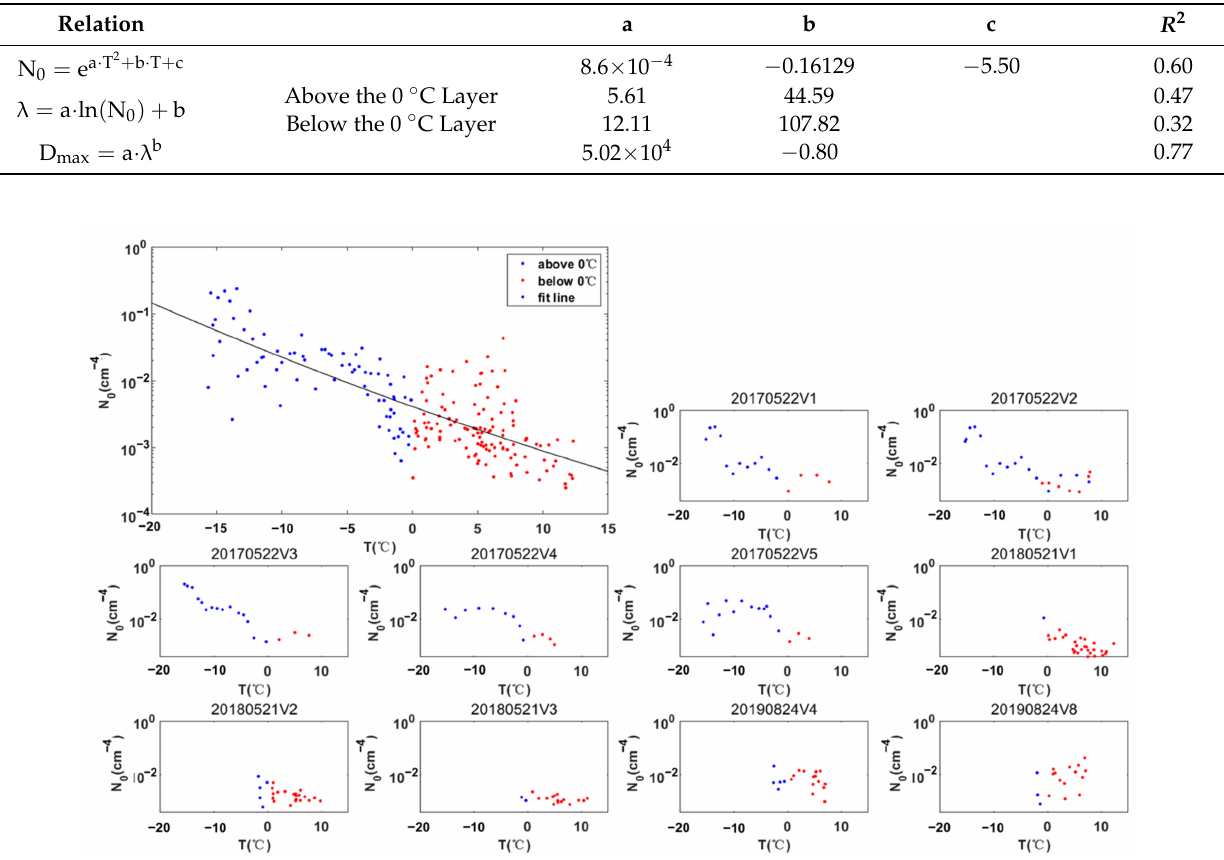
Figure 17. The relationship of N 0 and T .